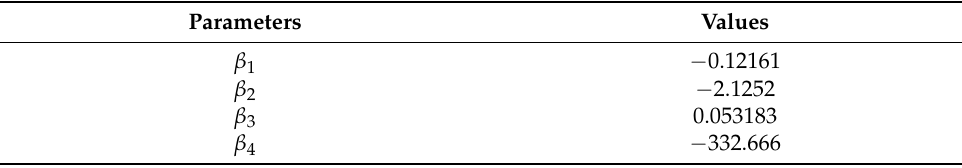
Table 2. Regression parameters for calculating f .